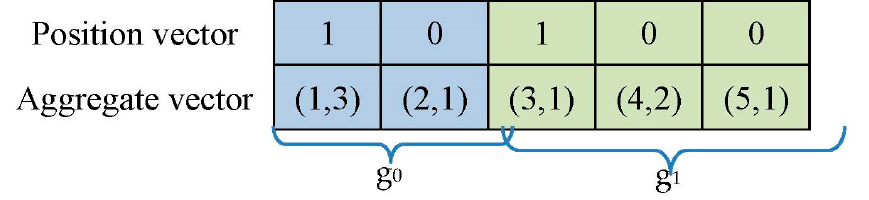
Figure 3. Aggregate vector of position vector.